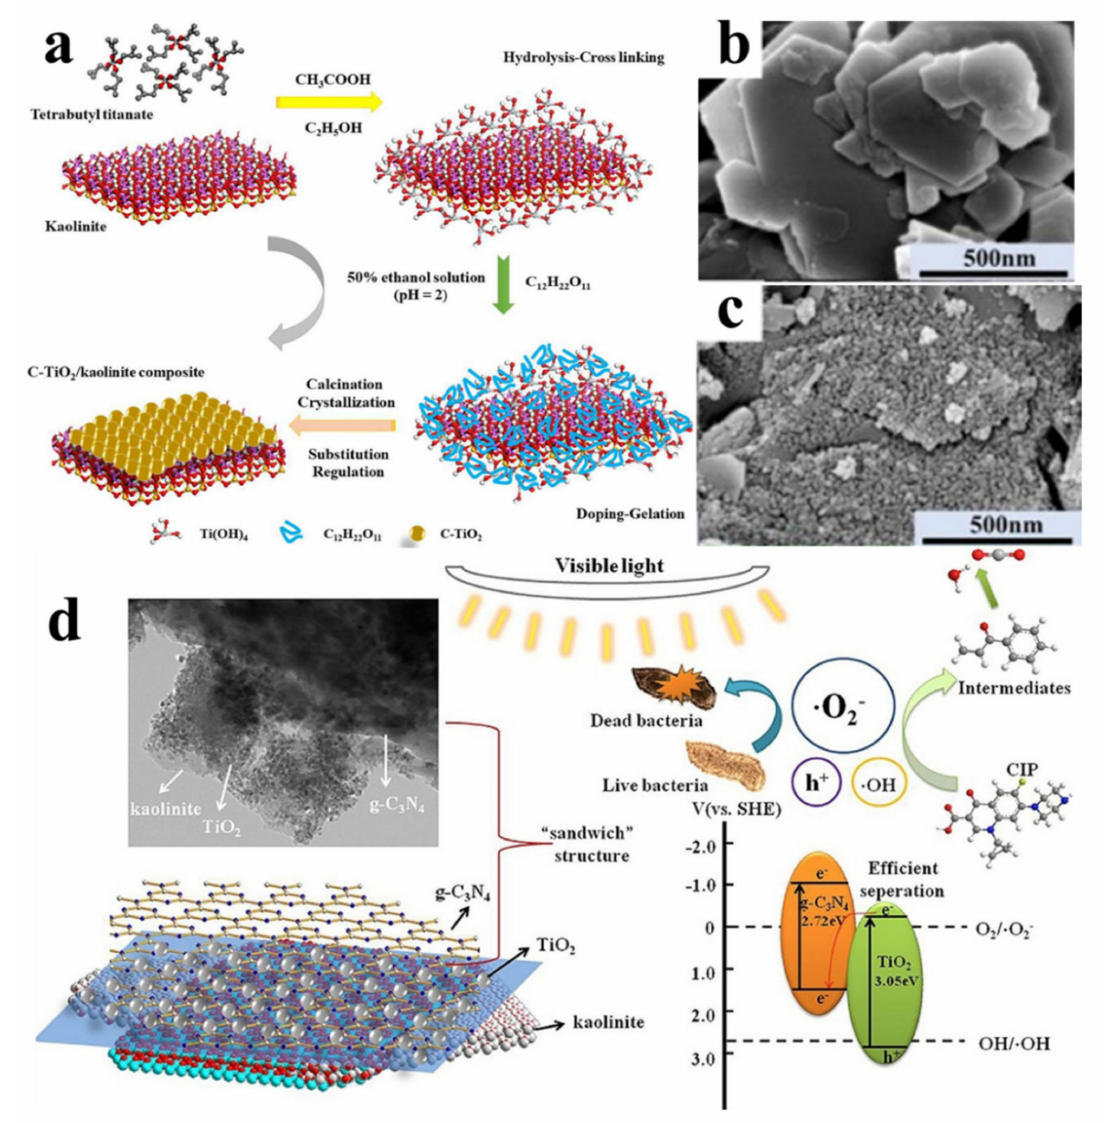
Figure 8. ( a ) The schematic diagram of the synthesis strategy of the prepared C-doped TiO 2 /kaolinite composite; field emission scanning electron microscope (FESEM) images of ( b ) kaolinite and ( c ) C-doped TiO 2 /kaolinite; ( d ) schematic diagram of the enhancement mechanism for the degrada- tion process under visible light towards g − C 3 N 4 /TiO 2 /kaolinite composite. Adapted with permis- sion from Ref. [5]. Copyright 2020, Elsevier B.V; Adapted with permission from Ref. [182].